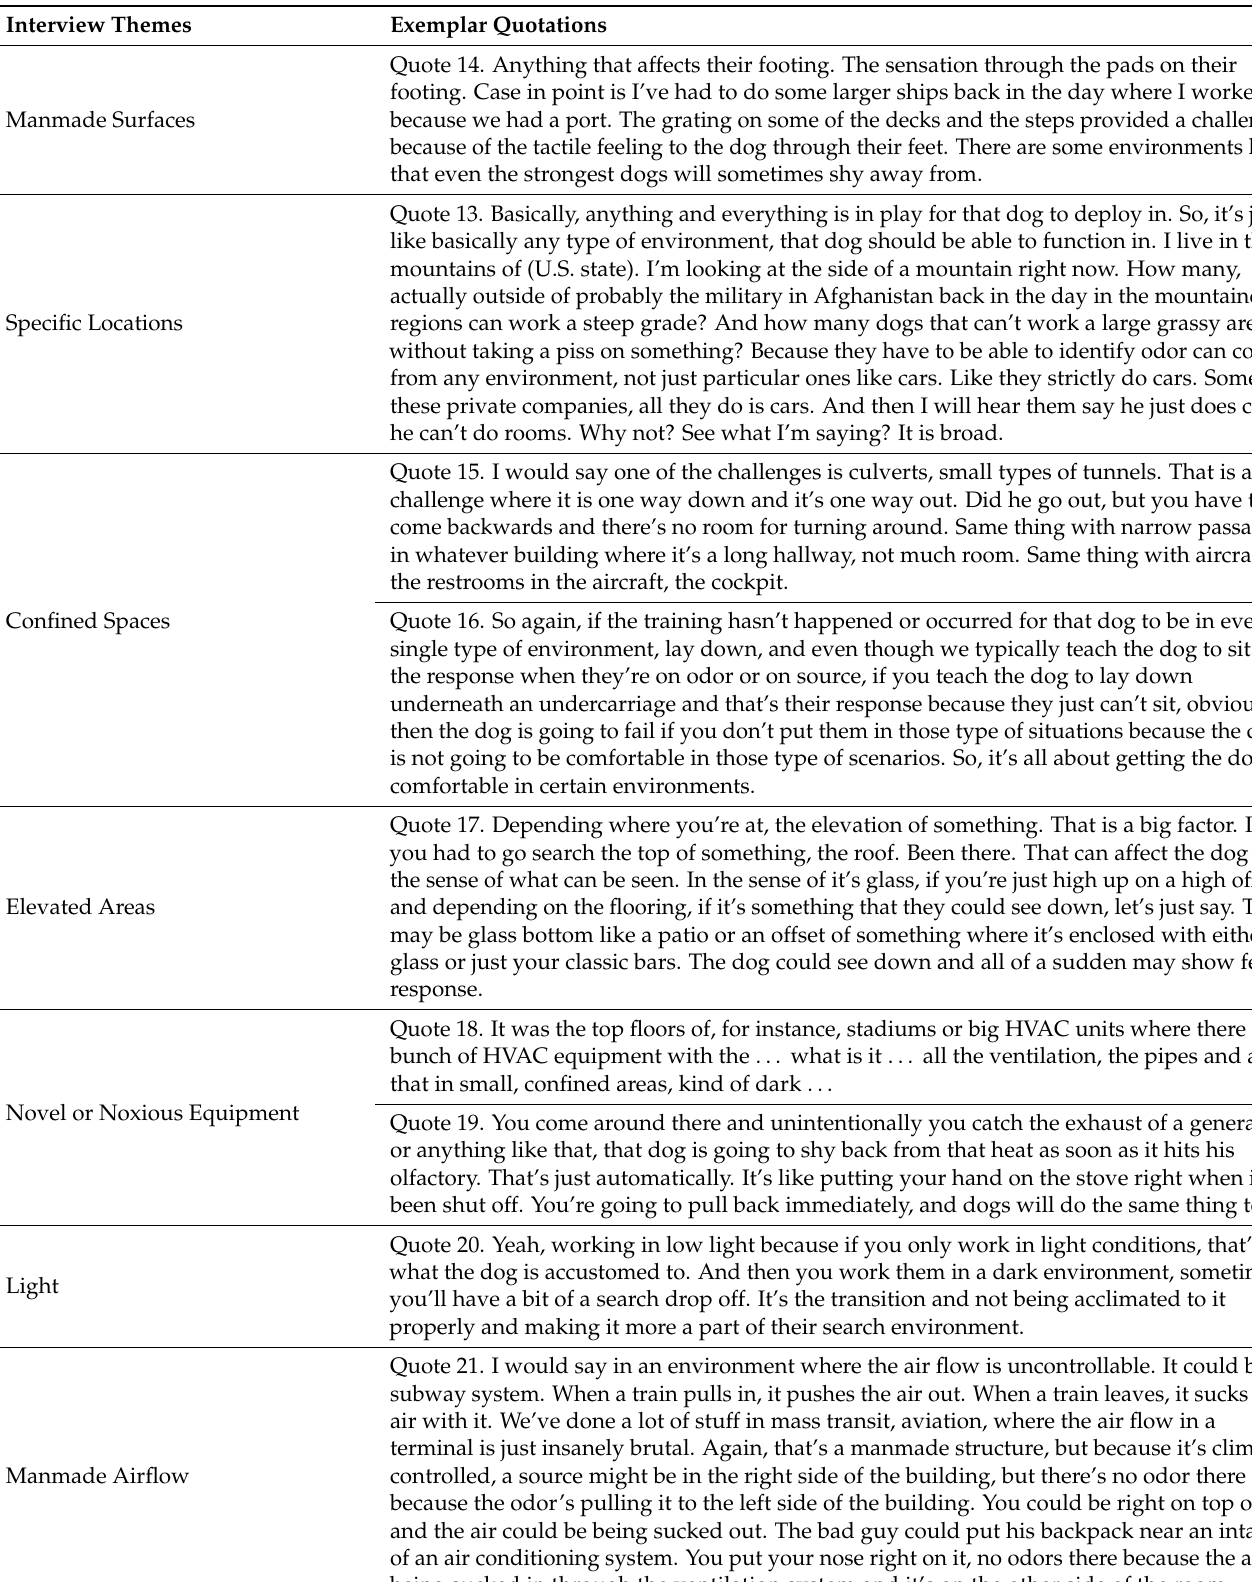
Table 4. Manmade physical environmental factor themes and exemplar